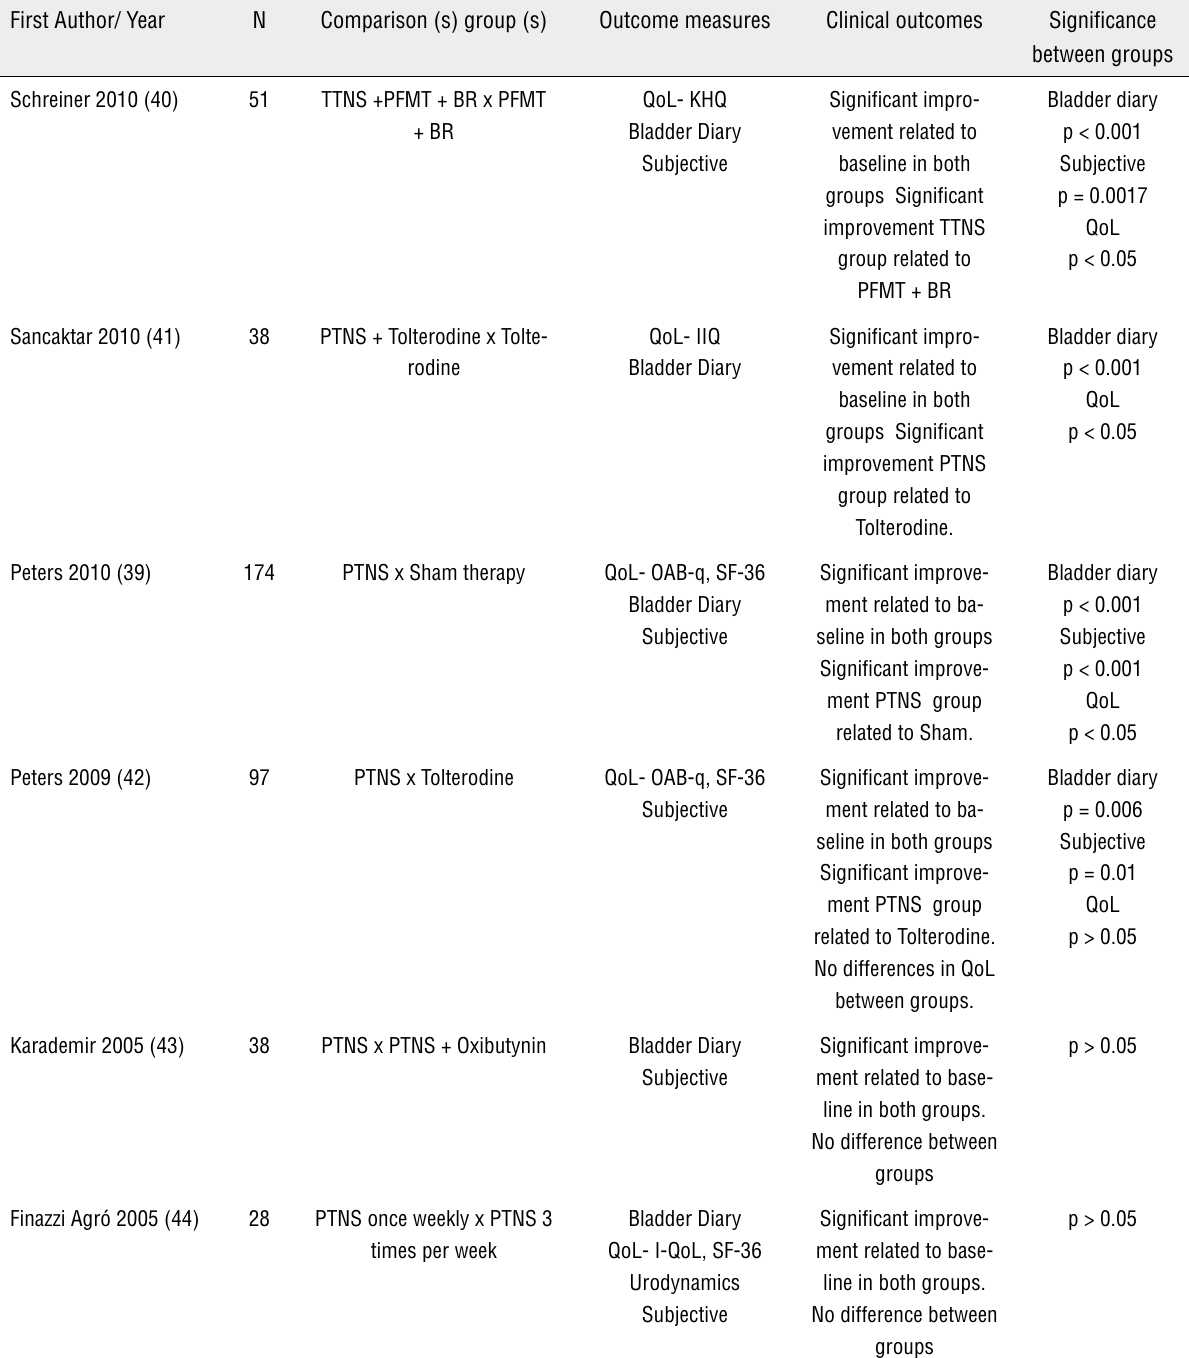
Table 4 - Outcome parameters of tibial nerve stimulation in urinary